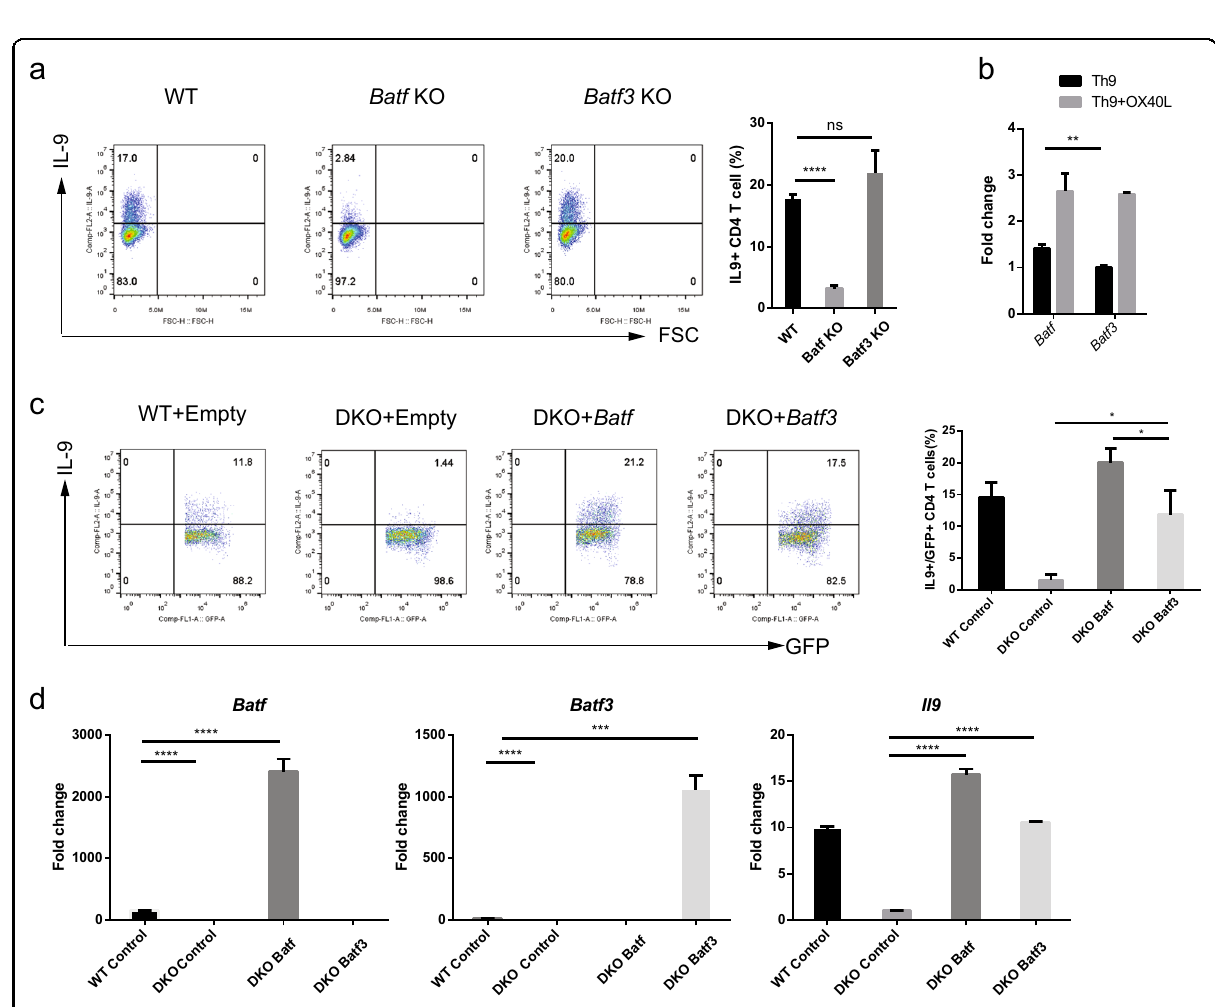
Fig. 4 BATF and BATF3 play redundant roles and compensate for each other. a Naive CD4 + T cells from WT, Batf KO, and Batf3 KO mice were cultured for 3 days under Th9 + OX40L conditions, and were then stimulated for 4 h with PMA and ionomycin. IL-9 production by cells was measured by fl ow cytometry. b Expression of Batf and Batf3 mRNA in the presence or absence of OX40L. c Naive CD4 + T cells were isolated from the spleens of WT or Batf-Batf3 DKO mice and then cultured for 3 days under Th9 + OX40L conditions. Cells were transfected with Batf or Batf 3 expression constructs. Transduced cells were gated for GFP, and IL-9 production was measured by fl ow cytometry. d Transduced cells were sorted by fl ow cytometry, and RNA was isolated. The expression of Batf , Batf3 , and Il9 mRNA was measured by qRT-PCR. Error bars represent the s.d. P values were calculated using Student ’ s t -tests. * P < 0.05, ** P < 0.01, and *** P < 0.001. All experiments were repeated independently three